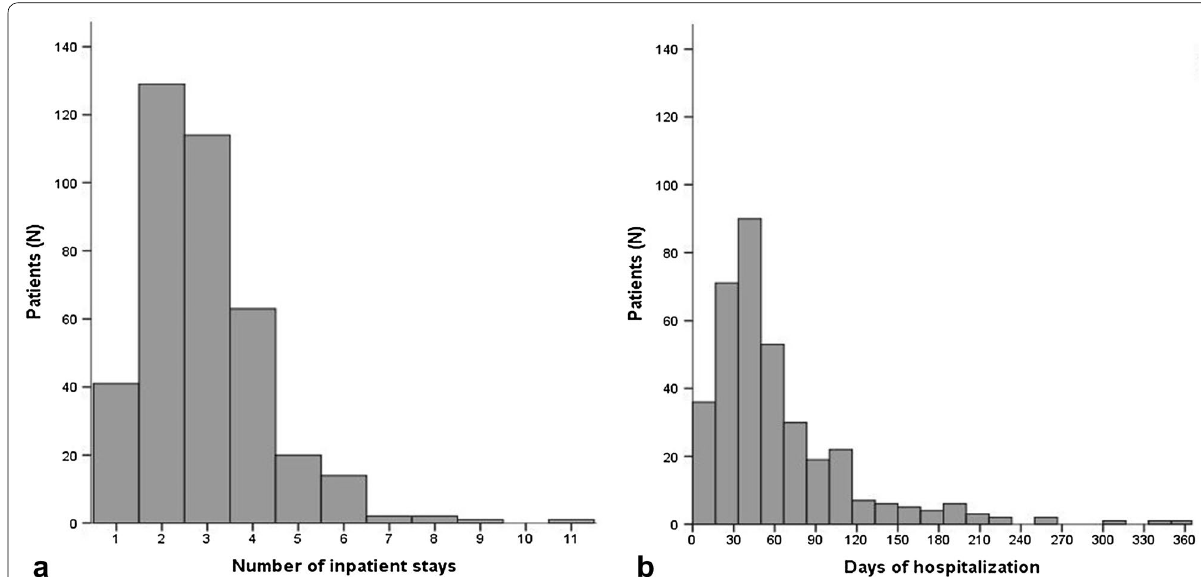
Table 2 Study participants’ outpatient visits during the first year after discharge from ICU according to medical specialty